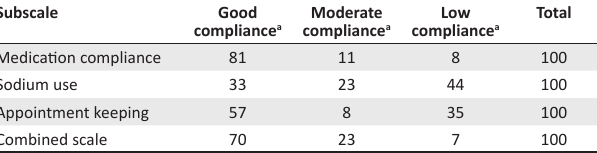
TABLE 3: Combined results of the Hill-Bone Compliance to High Blood Pressure Therapy Scale in